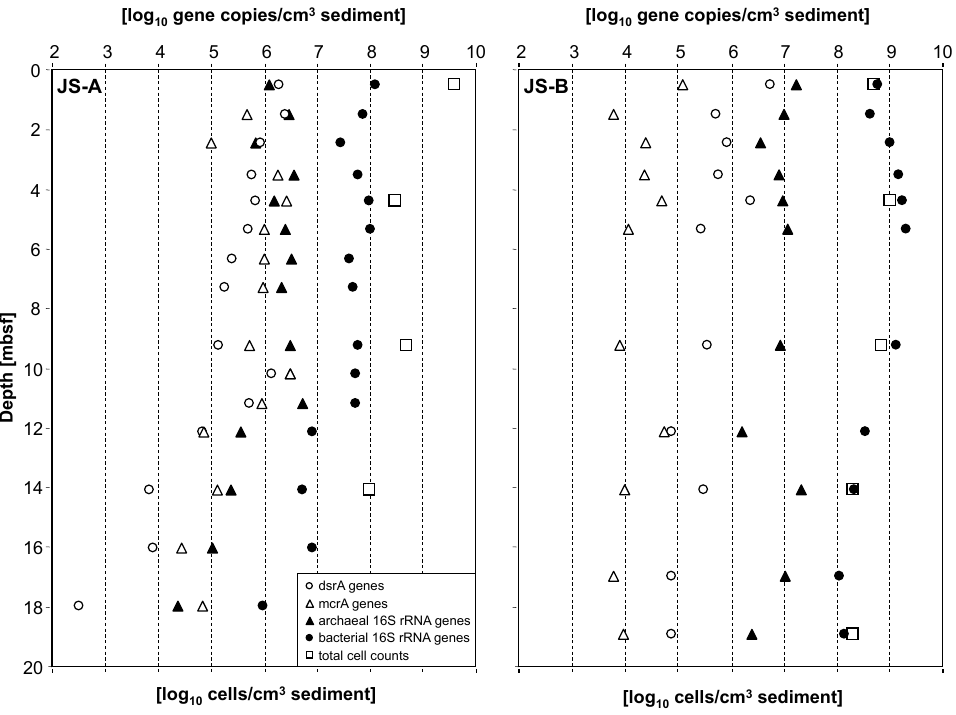
Fig. 5. Total cell counts and abundances of bacterial and archaeal 16S rRNA gene copies, dsr A and mcr A gene copies at sites JS-A and JS-B. Total cell counts were directly obtained by means of SybrGreen staining, whereas others were obtained by quantitative PCR. Core JS-B exhibits constant depth profiles for all quantifications. In contrast, a drop in all quantifications by one order of magnitude was found below the lithological boundary at 12mbsf of core